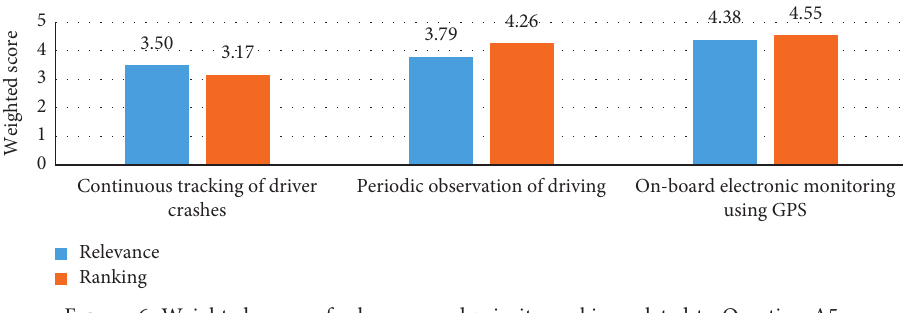
Figure 6: Weighted mean of relevance and priority ranking related to Question A5.